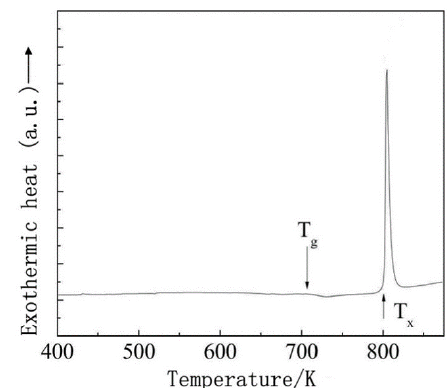
Figure 8. DSC curve of continuous casting Zr